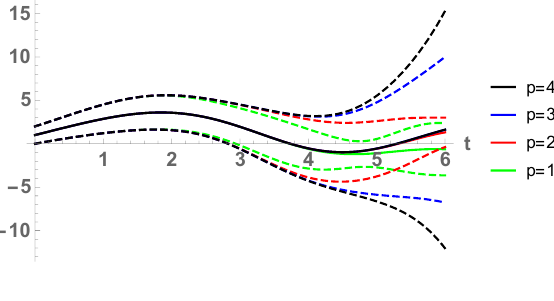
Figure 2: Expectation and confidence interval for the solution stochastic process, for orders of basis p = 1, 2, 3, 4 . Example 4.1, assuming dependent random